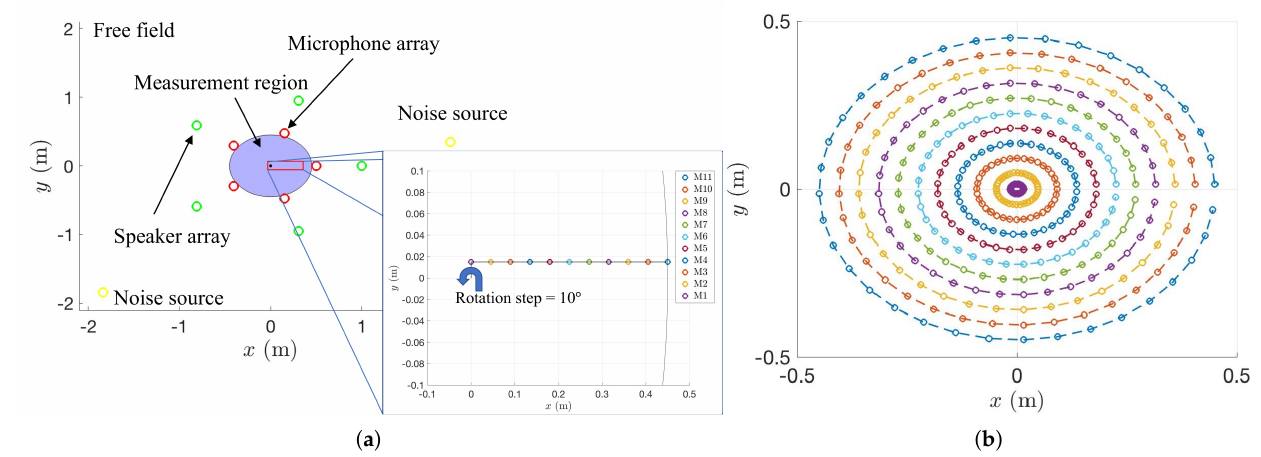
Figure 10. ( a ) Experimental geometry and ( b ) measurement